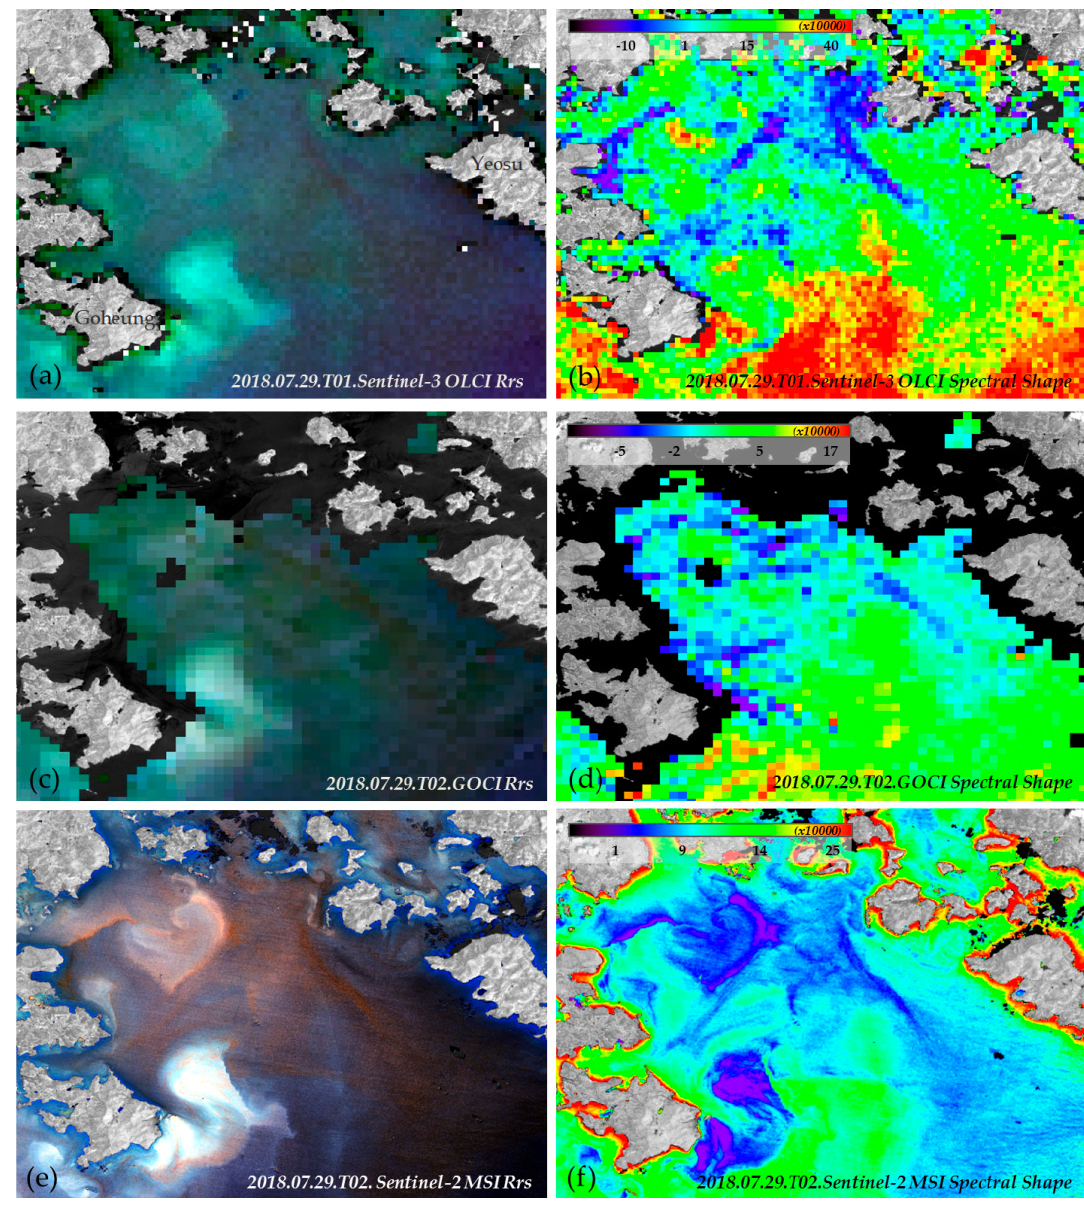
Figure 5. R rs true-color composite and Spectral Shape images from various sensors on 29 July 2018 at Bodolbada. ( a ) Sentinel-3 OLCI R rs true-color composite image (R: 681.25 nm; G: 560 nm; B: 442.5 nm), ( b ) Sentinel-3 OLCI Spectral Shape image, ( c ) GOCI R rs true-color composite image (R: 680 nm; G: 555 nm; B: 490 nm), ( d ) GOCI Spectral Shape image, ( e ) Sentinel-2 MSI R rs true-color composite image (R: 680 nm; G: 560 nm; B: 490 nm), ( f ) Sentinel-2 MSI Spectral Shape image.